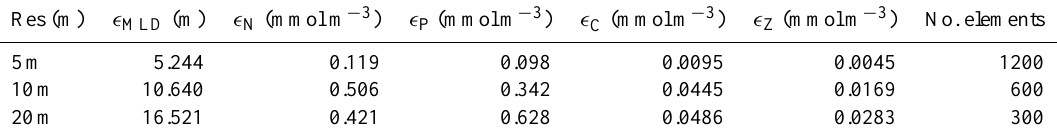
Table 2. The rms error, (cid:15) , of fixed-mesh simulations compared to the simulation with 2.5m vertical resolution at Station Papa. (cid:15) is shown for MLD, and the L2 norm of nutrient, primary productivity, chlorophyll and zooplankton. See Fig. 6 also.